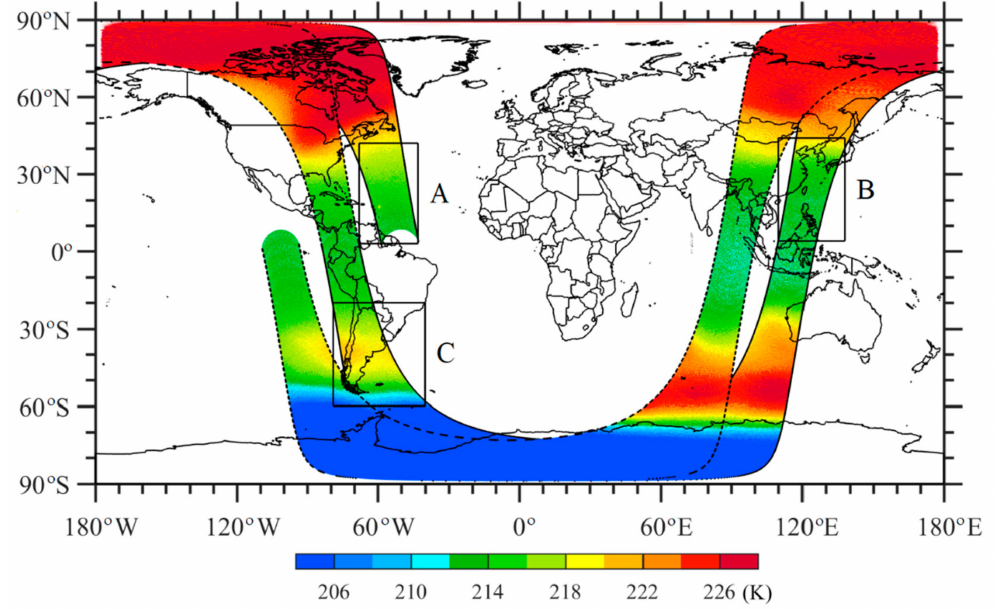
Figure 3. TB observations at channel 5 over two sequential swaths on 5 September 2017. One swath had its observation times from 1915 to 2057 UTC (edges indicated by a black solid curve) and the other swath from 2057 to 2238 UTC (edges indicated by a black dash curve). Three areas with 300 scanlines (black boxes) are also indicated: area A is at the ascending node over the western Northern Hemisphere, area B is at the descending node over the eastern Northern Hemisphere, and area C is at the ascending node over the western Southern